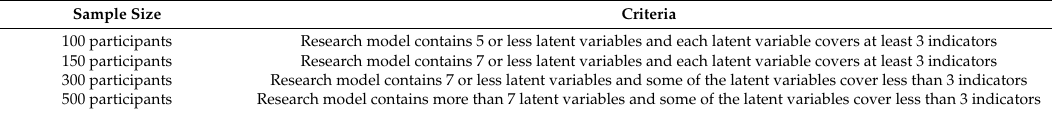
Table 1. Minimum sample size in SEM (Structural Equation Modelling) according to Hair, Black [41].